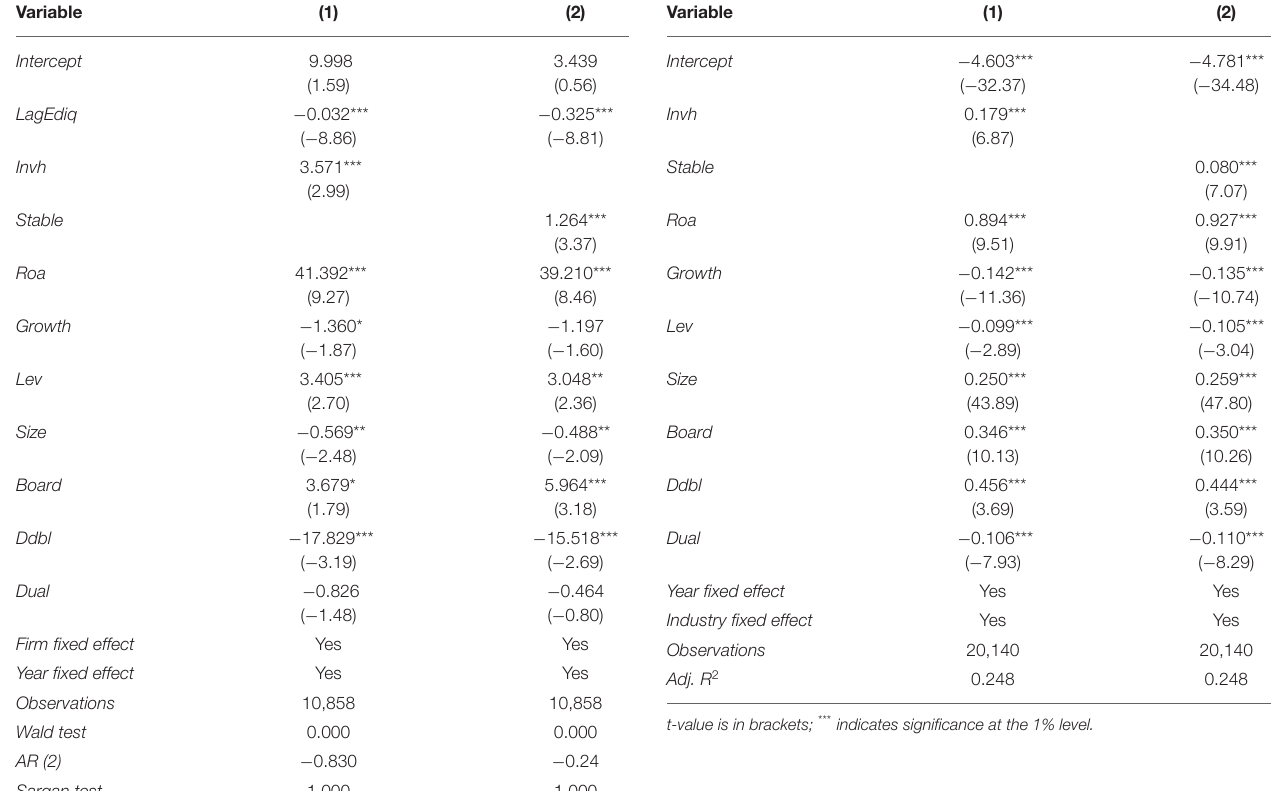
TABLE 8 | Institutional investors’ heterogeneity and environmental information disclosure quality: difference-GMM dynamic panel analysis. Variable